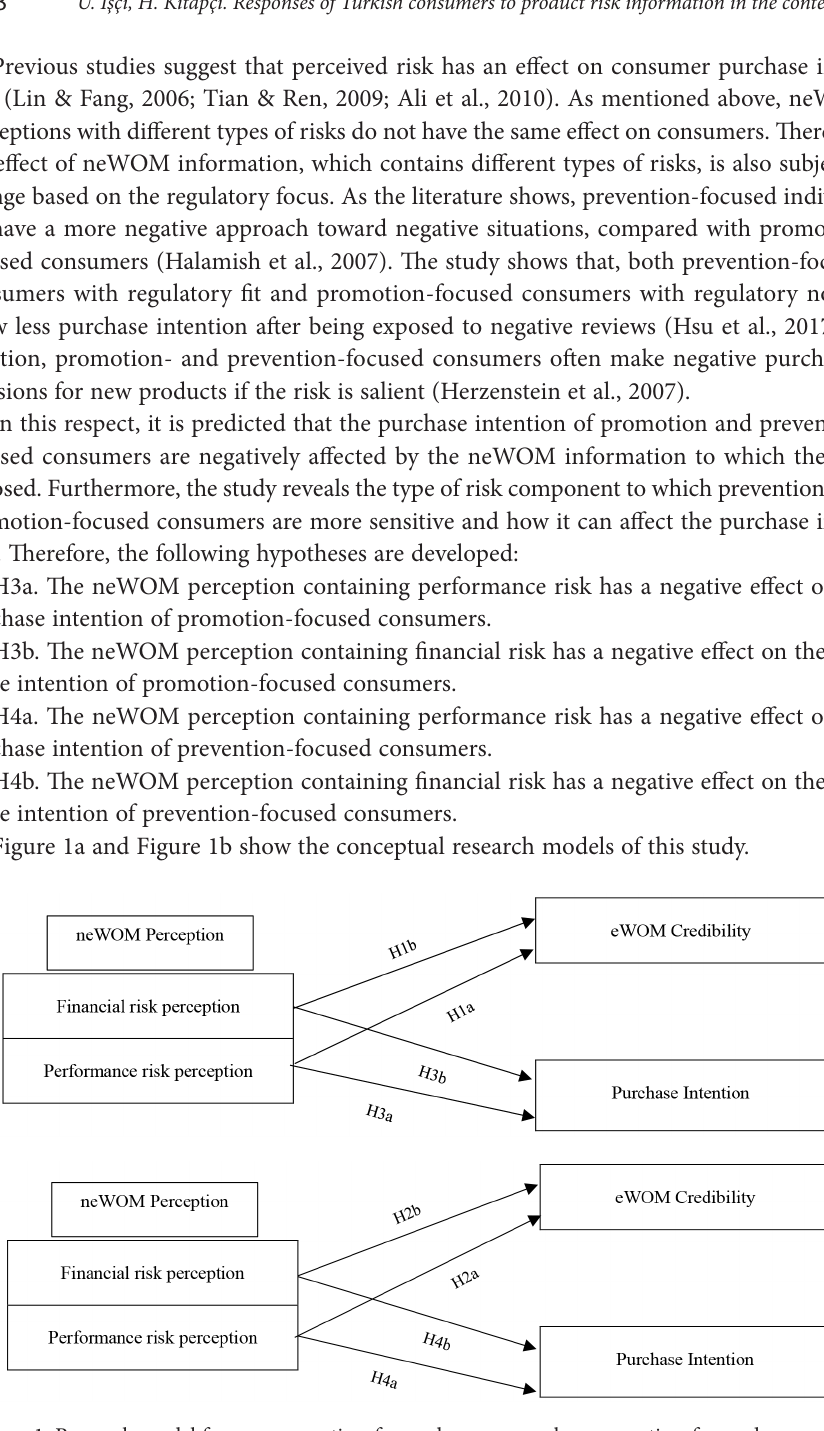
Figure 1. Research model for: a – promotion-focused consumers; b –